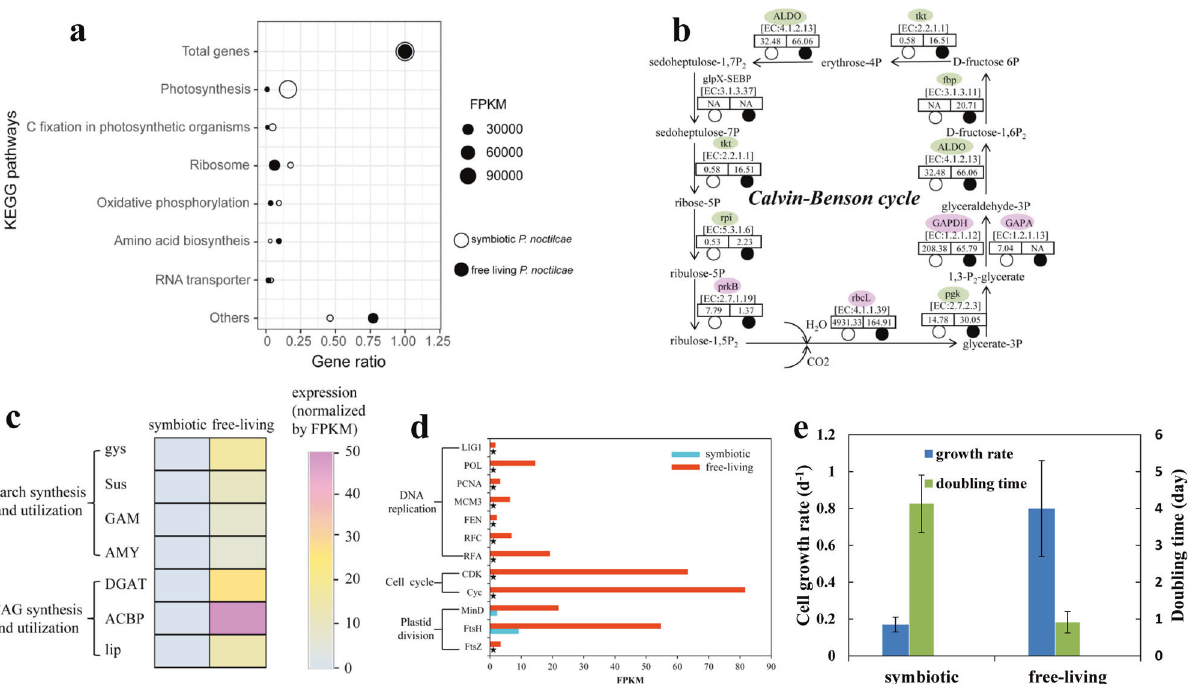
Fig. 4 Transcriptomic proofs of host manipulation for photosynthates. a Enrichment of KEGG pathways in both in-hospite and free-living P. noctilucae , indicating photosynthesis was the most dominant metabolic activity in in-hospite P. noctilucae . b Expression of genes involved in Calvin-Benson cycle. Pink (green) denotes higher (lower) expression in in-hospite P. noctilucae . Expression level (FPKM) of each gene in both in- hospite and free-living P. noctilucae are indicated in the relevant boxes. c Low starch and TAG metabolisms in the in-hospite P. noctilucae . d Low cell division and relatively high plastid division in the in-hospite P. noctilucae . Asterisks depict the absence of genes in the metatranscriptomics data. e Low growth rate (d − 1 ) and longer cell doubling time (days) of the in-hospite P. noctilucae compared to free-living counterparts under laboratory incubation. Error bar stands for standard